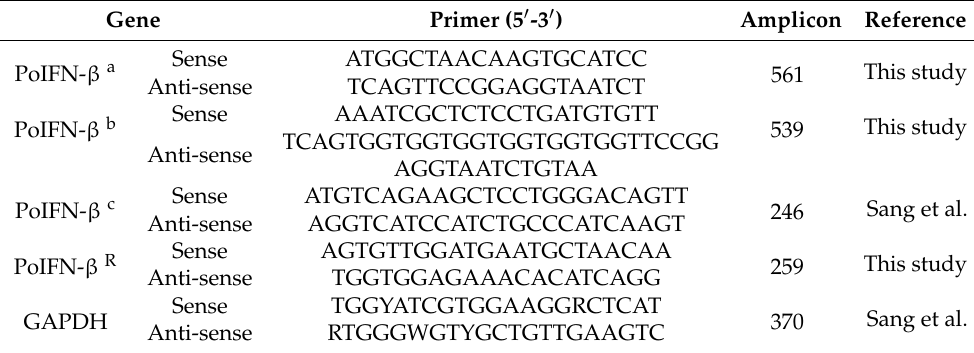
Table 1. PCR primers used in this